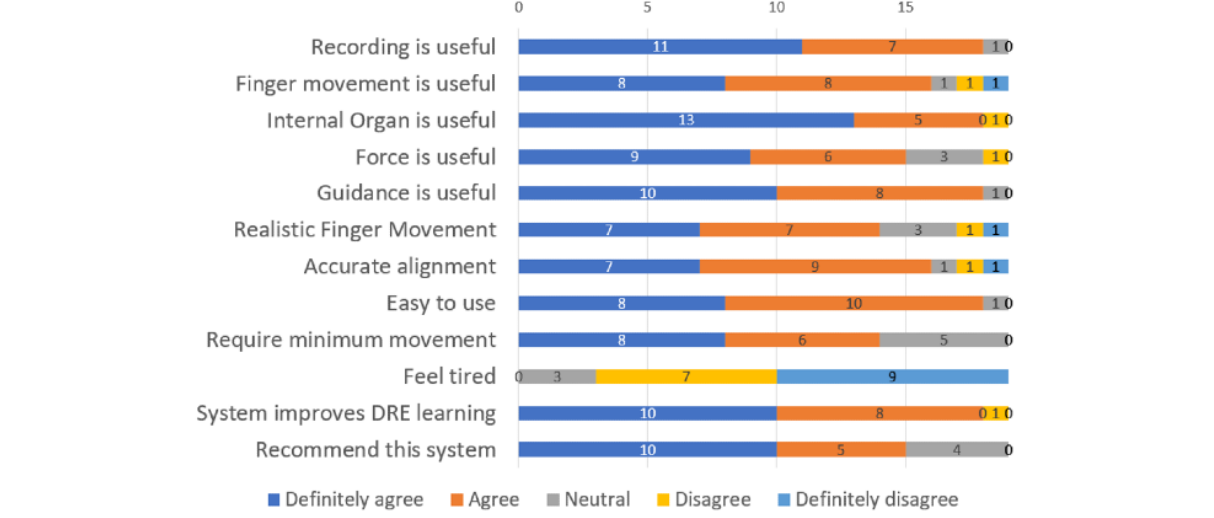
Figure 14. Results from the Likert-scale questionnaire. The numbers and hence the length of each bar indicate the number of participants choosing that rate. DRE: digital rectal examination.